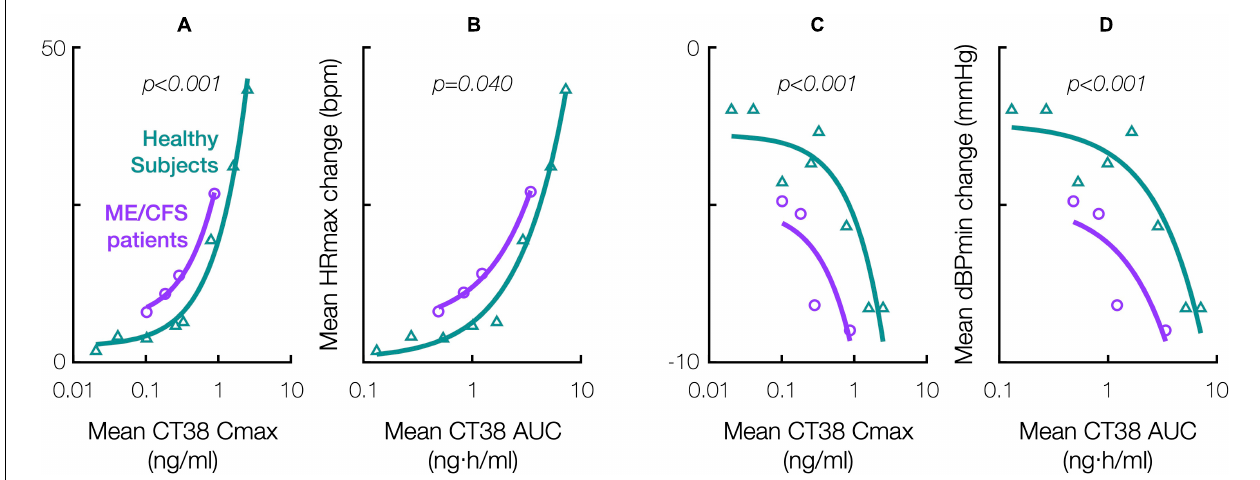
FIGURE 4 | Effect of CT38 in healthy subjects (triangles, green line) and ME/CFS patients (circles, purple line), on the change from baseline in: mean maximum HR (HRmax) versus (A) mean Cmax or (B) mean AUC; and mean minimum dBP (dBPmin) versus (C) mean Cmax or (D) mean AUC; with relevant p -values (italics) from statistical comparisons by Kolmogorov-Smirnov test.